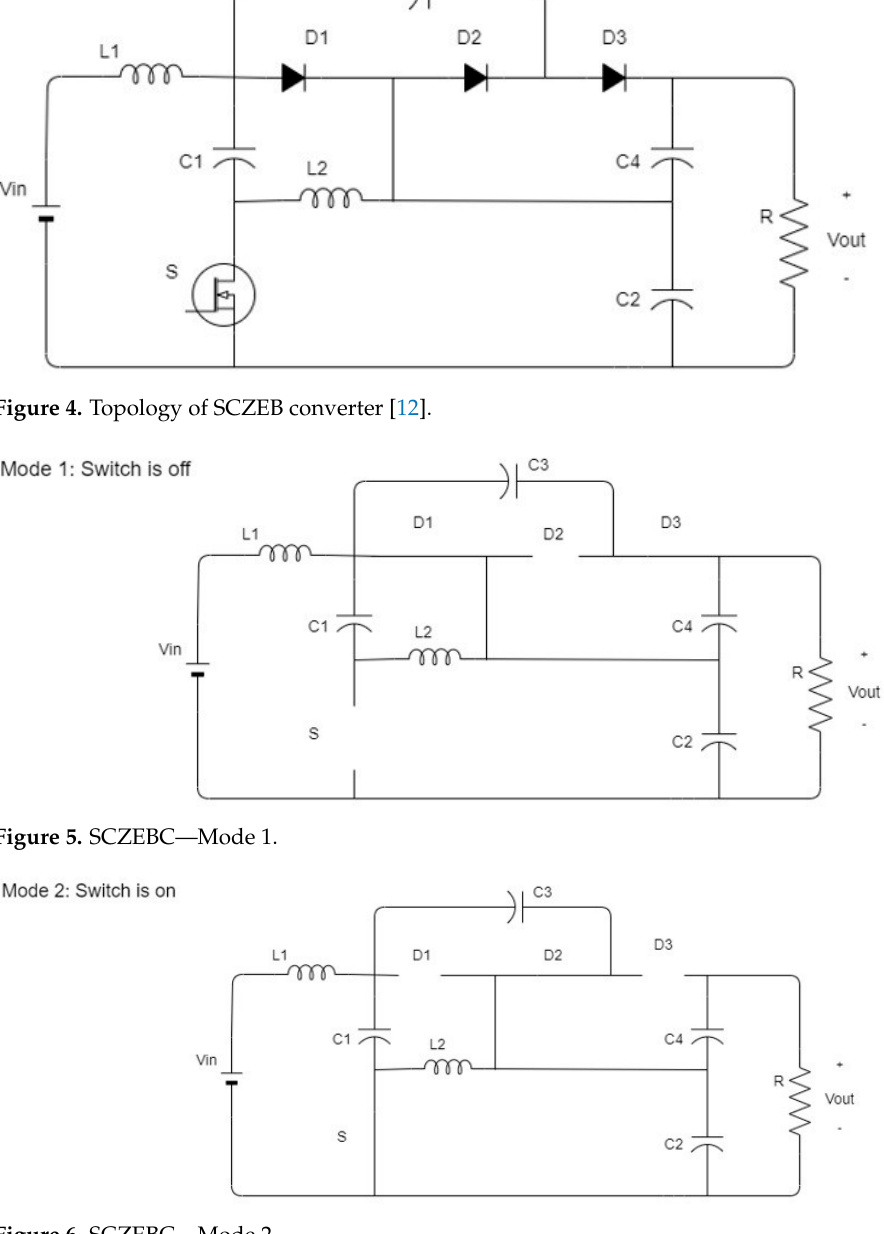
Figure 6. SCZEBC—Mode 2.